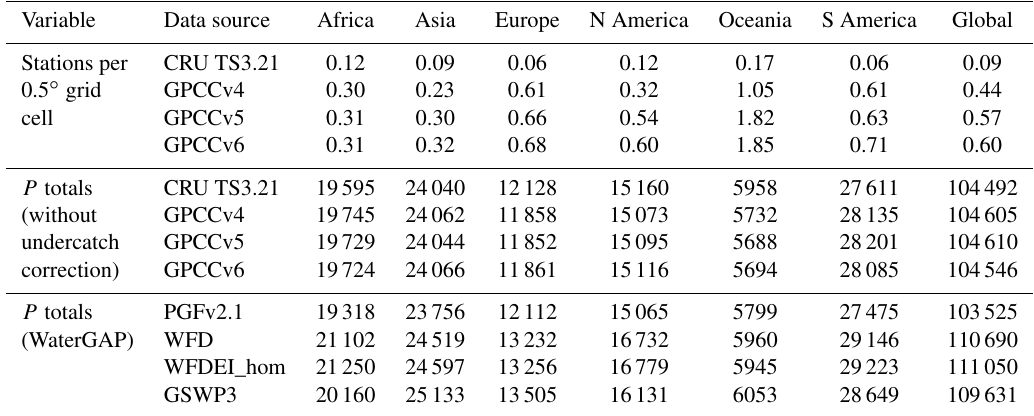
Table 4. Average density of precipitation gauging stations and P sums (km 3 yr − 1 ) for 1971–2000 of the original P data that were used for bias correction (WFD: GPCCv4, WFDEI: GPCCv5, GSWP3: GPCCv6, PGFv2.1: CRU TS3.21) and P outputs of WaterGAP using the undercatch adjusted forcings (except PGFv2.1 which is not